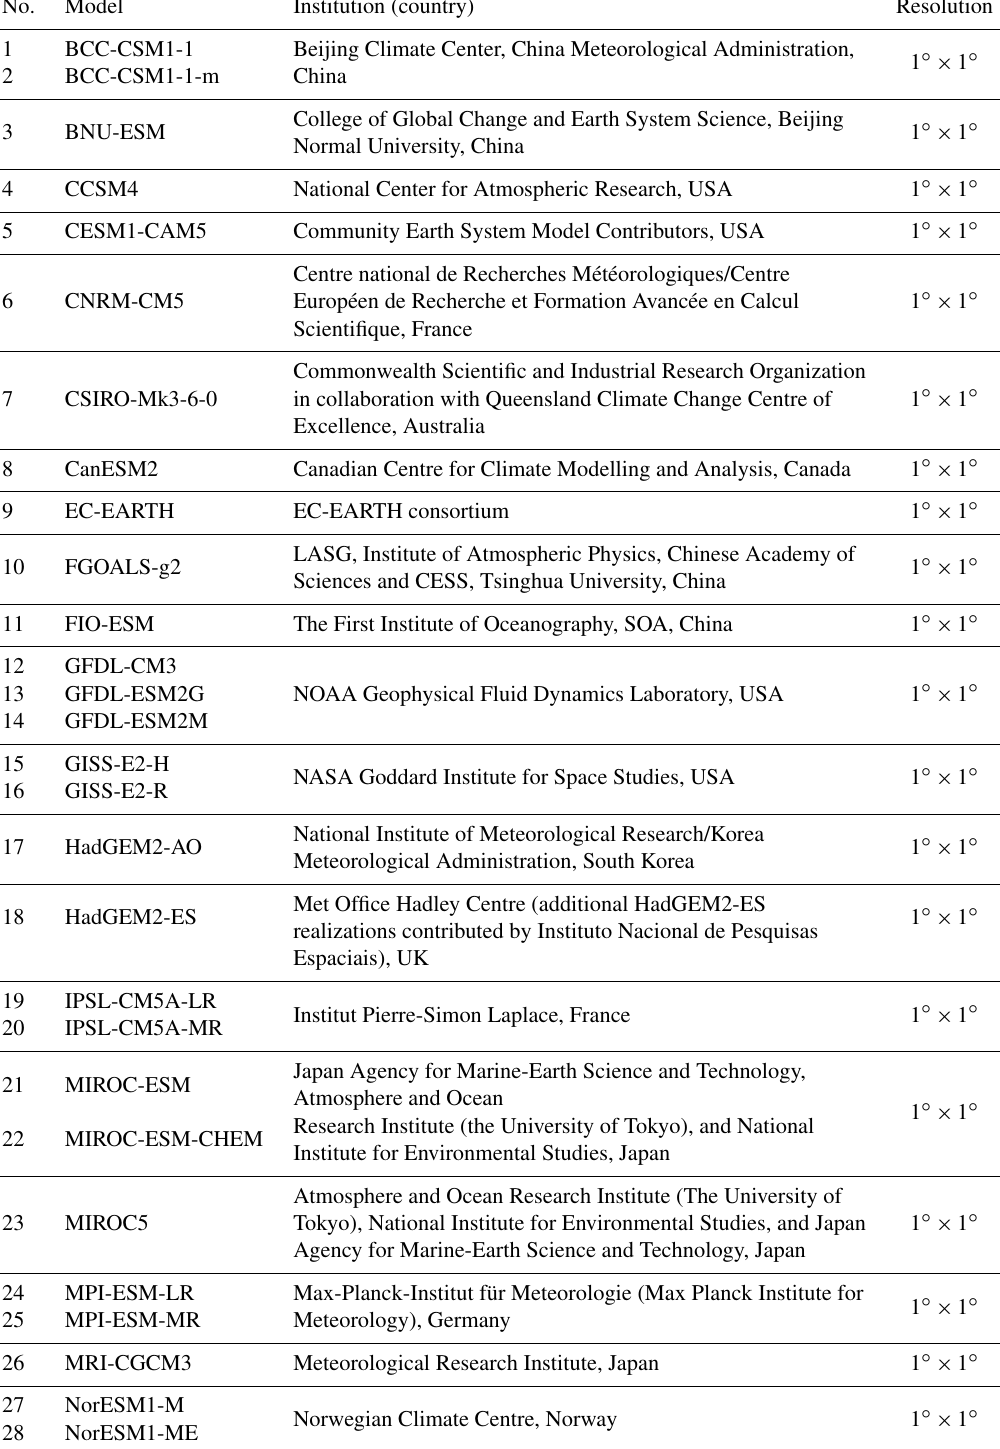
Table 1. CMIP5 GCMs used in this study. The GCM data were statistically downscaled and regridded onto a common 1 ◦ × 1 ◦ global grid from the Canadian Climate Data and Scenarios